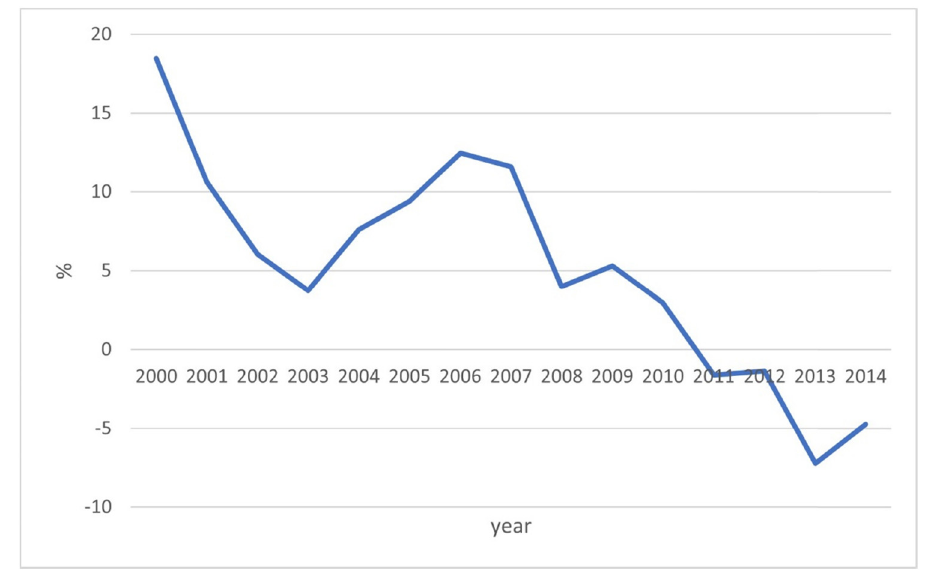
Figure 6: Yearly growth of credit to non fi nancial institutions. Source: Bank for International Settlements 3